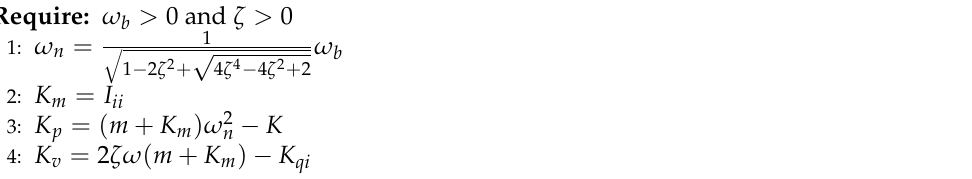
Algorithm 1 PD and acceleration feedback pole-placement algorithm